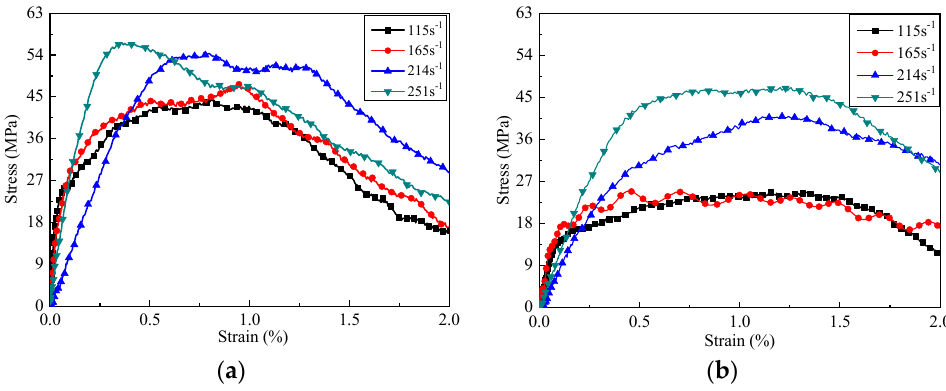
Figure 7. Stress–strain curves: ( a ) microcapsule-based specimen; ( b ) non-microcapsule specimen.